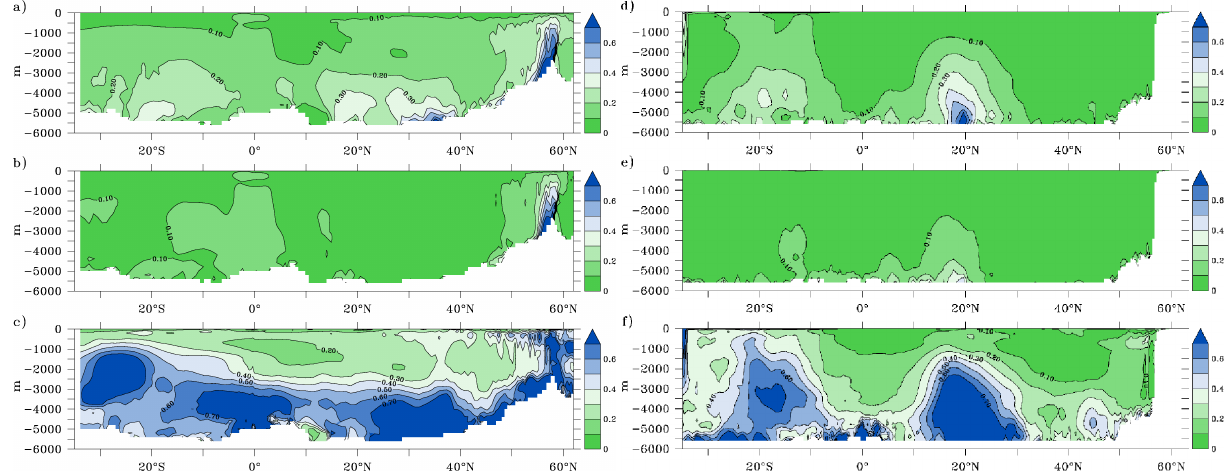
Fig. 16. Ratio between chaotic and total MOC variability for the Atlantic (a) , (b) , (c) and Indo-Pacific (d) , (e) , (f) in the non-eddy-permitting experiments A100 and B100. (a) Ratio for unfiltered MOC variability (based on 5-day averages). (b) Ratio for subannual MOC variability. (c) Ratio for interannual MOC variability. (d) , (e) , (f) as a,b,c but for Indo-Pacific. The contour interval is